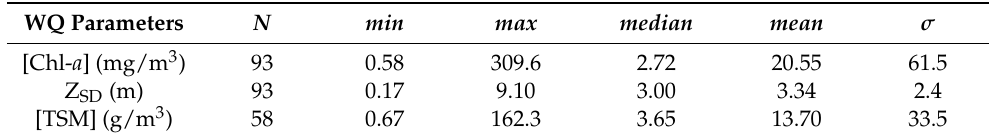
Table 5. Number of water quality measurements by type ( N ), their concentration ranges (min, max), median, mean and standard deviation ( σ